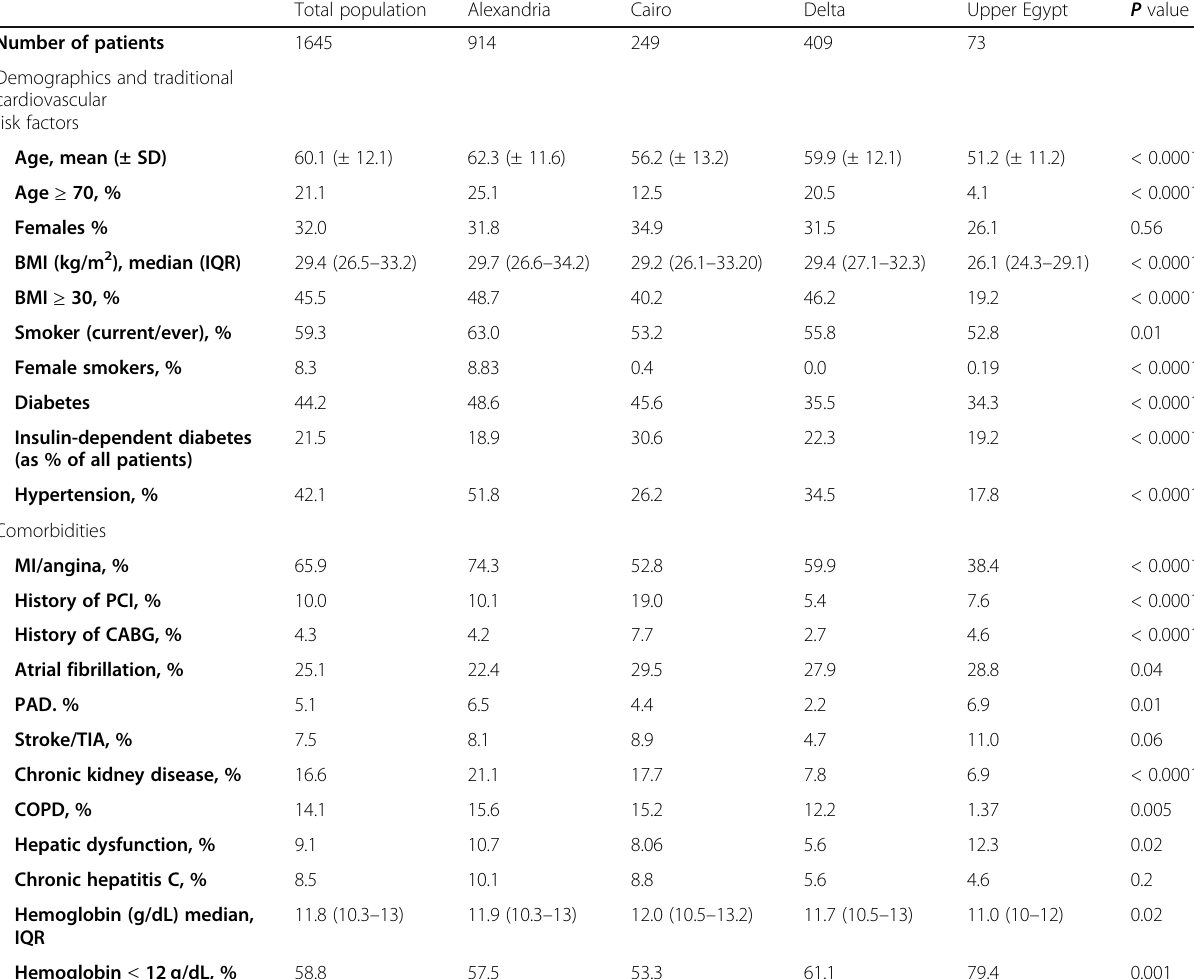
Table 1 Demographics, cardiovascular risk factors, and